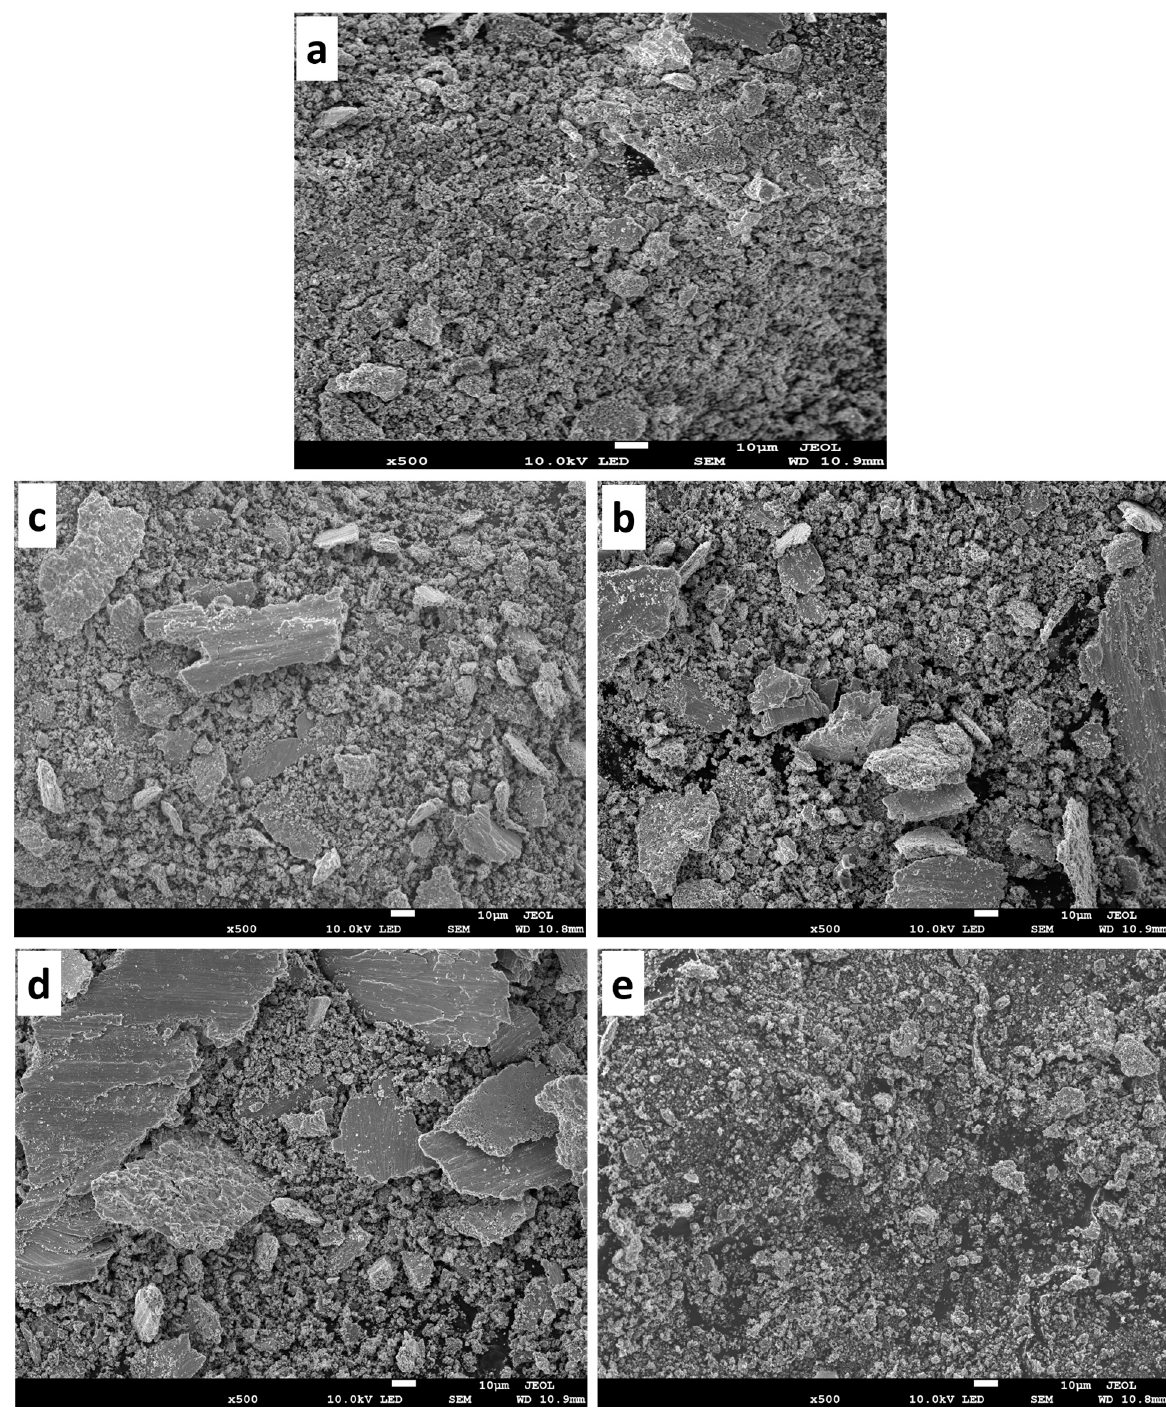
Figure 18. The wear debris of the sintered samples under 13 N ( a ) T0.0, ( b ) T2.5, ( c ) T5.0, ( d ) T7.5, and ( e )